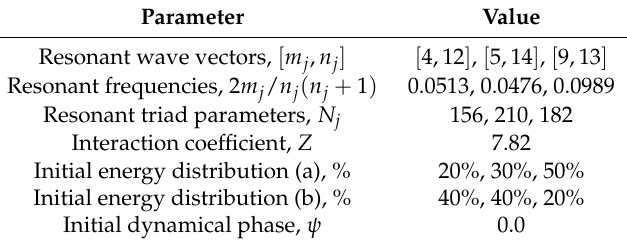
Table 1. Physical parameters used in numerical